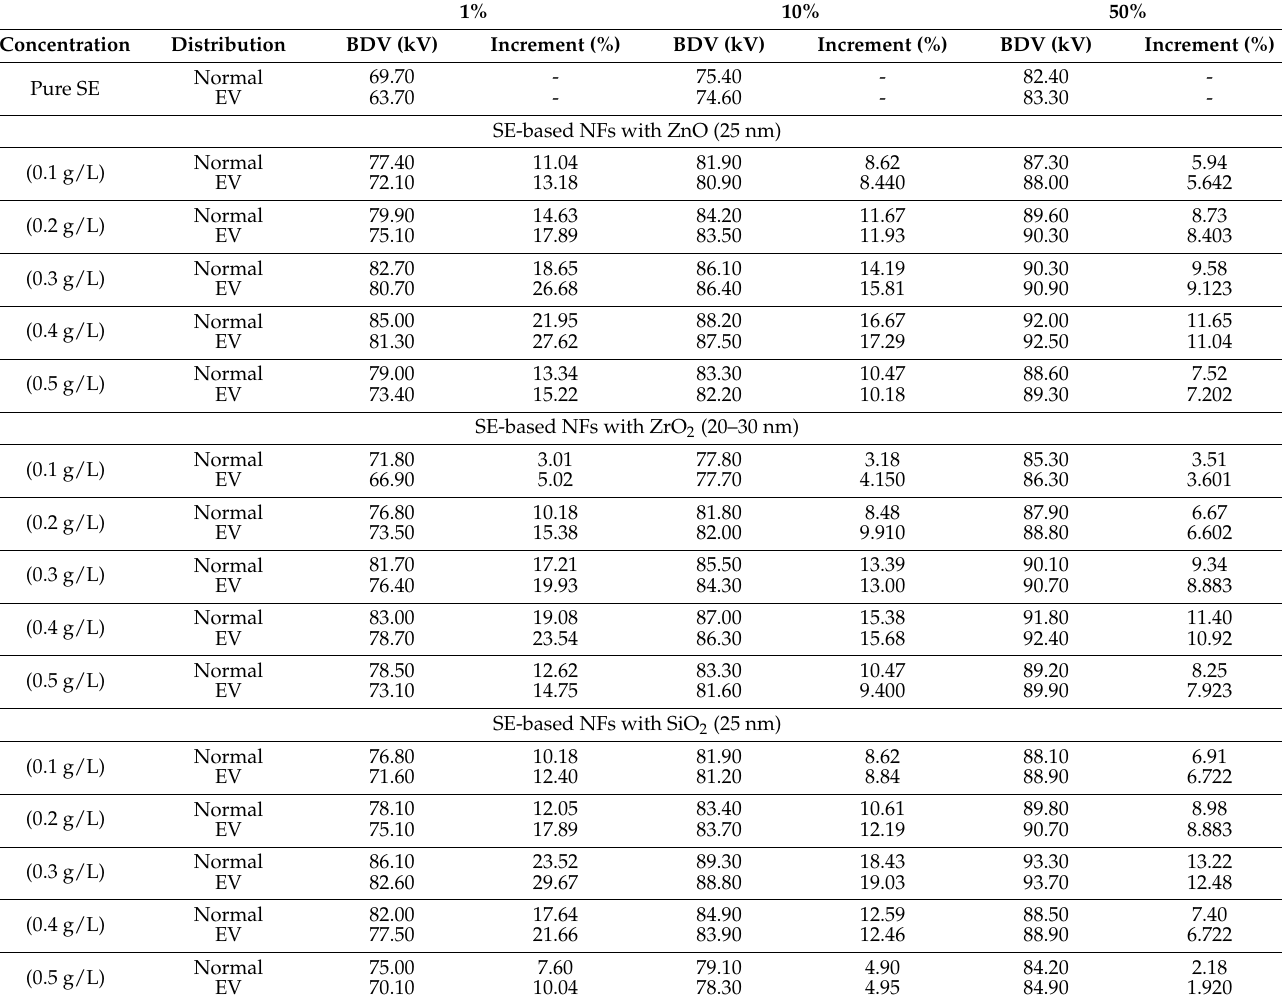
Table 8. PD activity of synthetic ester and synthetic ester-based nanofluids with Fe 3 O 4 (20 nm) and